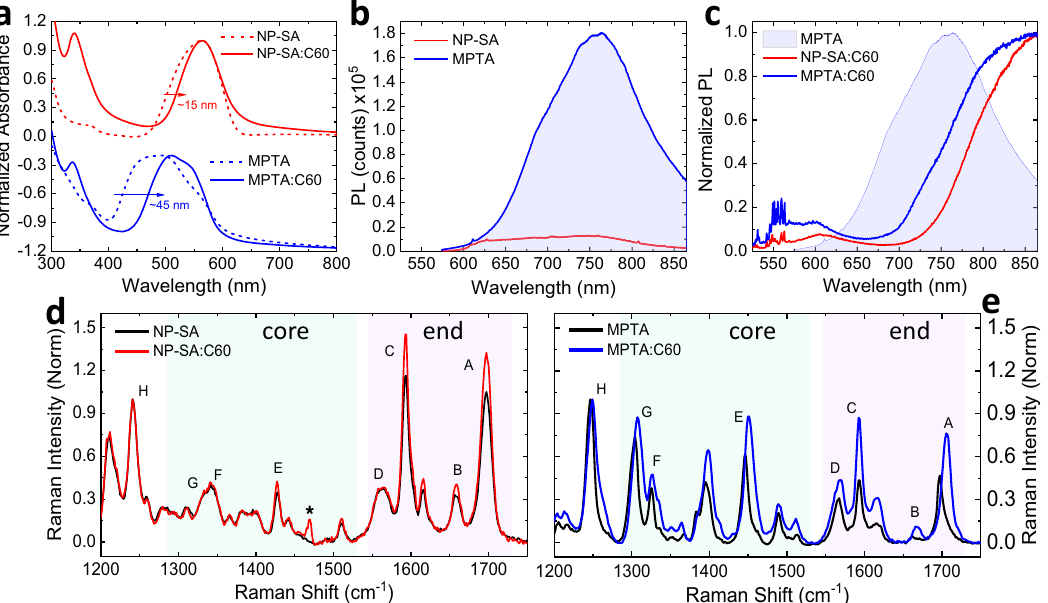
Fig. 3 Optical and molecular structural properties. a Normalized UV-Vis absorption spectra for NP-SA, MPTA and respective C 60 blends. b Absolute photoluminescence (measured by 514 nm excitation and corrected for absorbance) for neat donor thin fi lms. c Normalized PL for blends and neat MPTA, measured by 514 nm excitation. d , e Comparison between normalized Raman spectra (via 488 nm laser excitation) of neat and blended NP-SA and MPTA fi lms. The peaks are labeled according to the detailed assignment shown in the Supplementary Information and grouped according to core and end-group vibrational modes. The asterisk in ( d ) indicates the C 60 vibrational mode appearing in